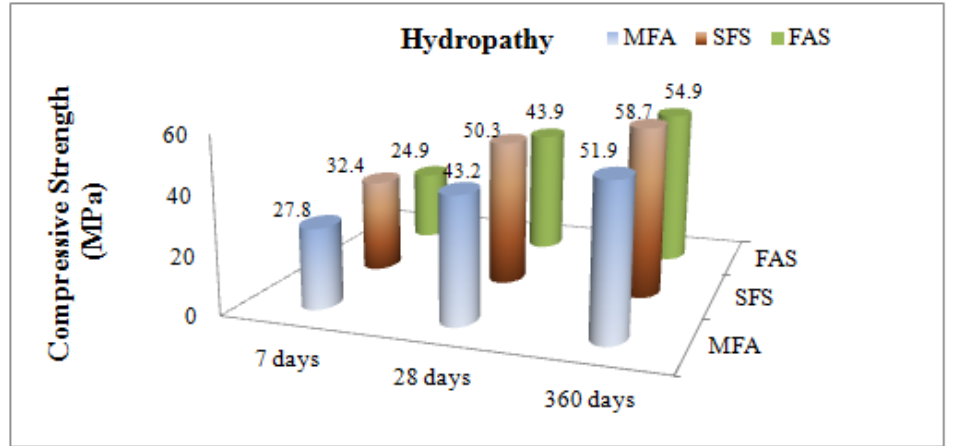
Figure 5. Effects of mineral admixtures on compressive strength of concrete for 7, 28 and 360 days in hydropathy.